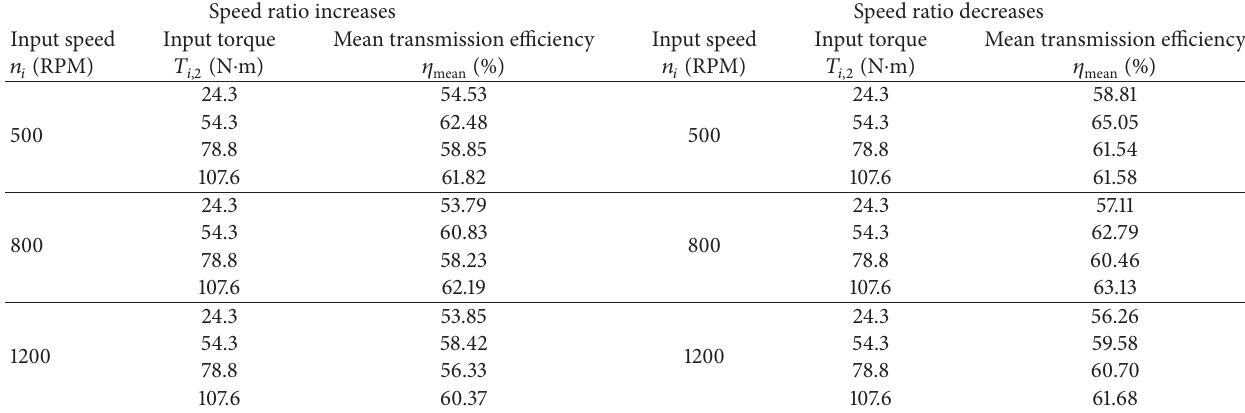
Table 4: Mean transmission efficiency of experimental results of